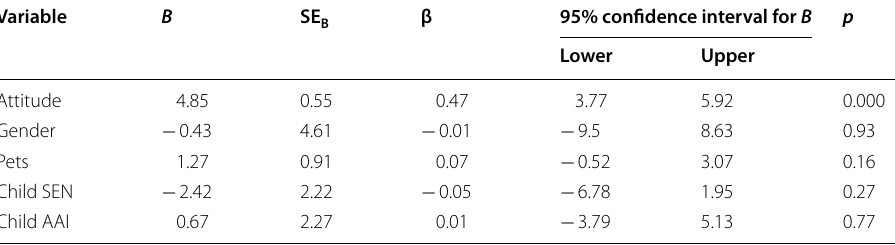
Table 4 Table to show regression coefficients, standard error and significance of demographics and attitude as predictors of